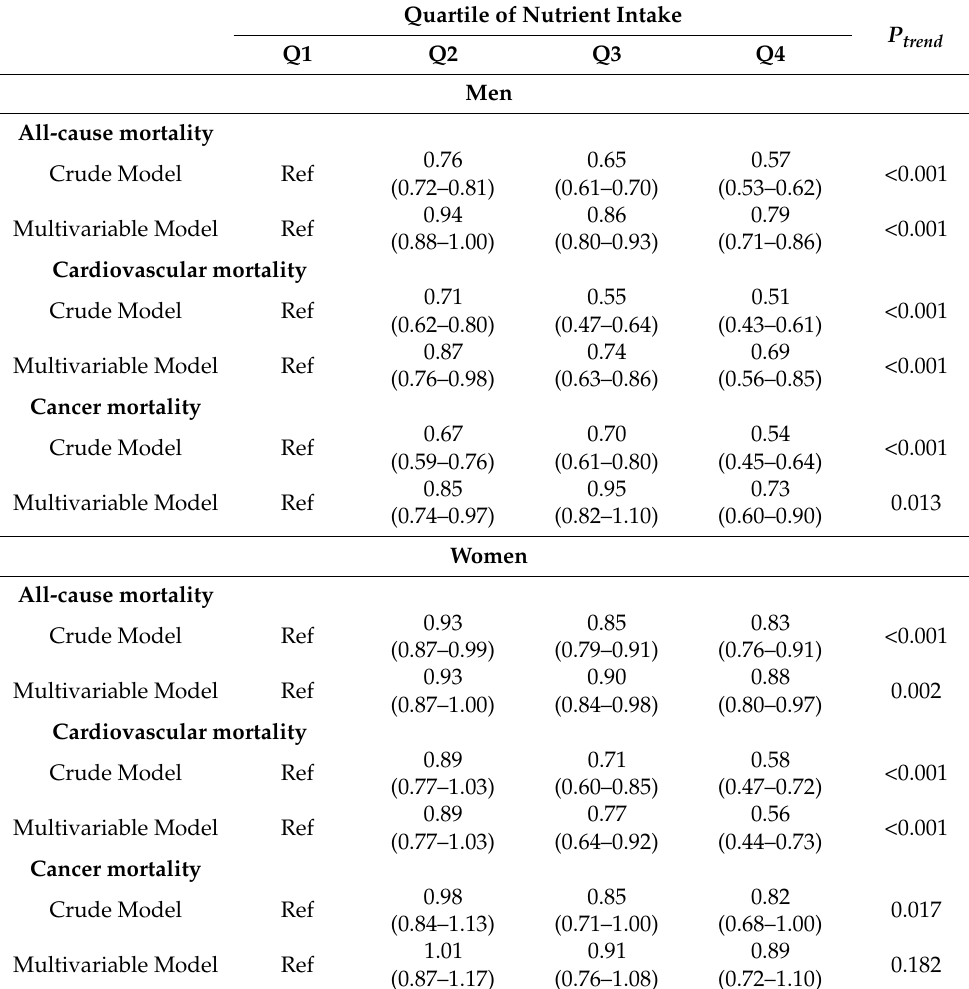
Table 3. Hazard Ratios (HRs) and 95% confidence intervals (CIs) for all-cause and cause-specific mortality according to the quintiles of dietary vitamin